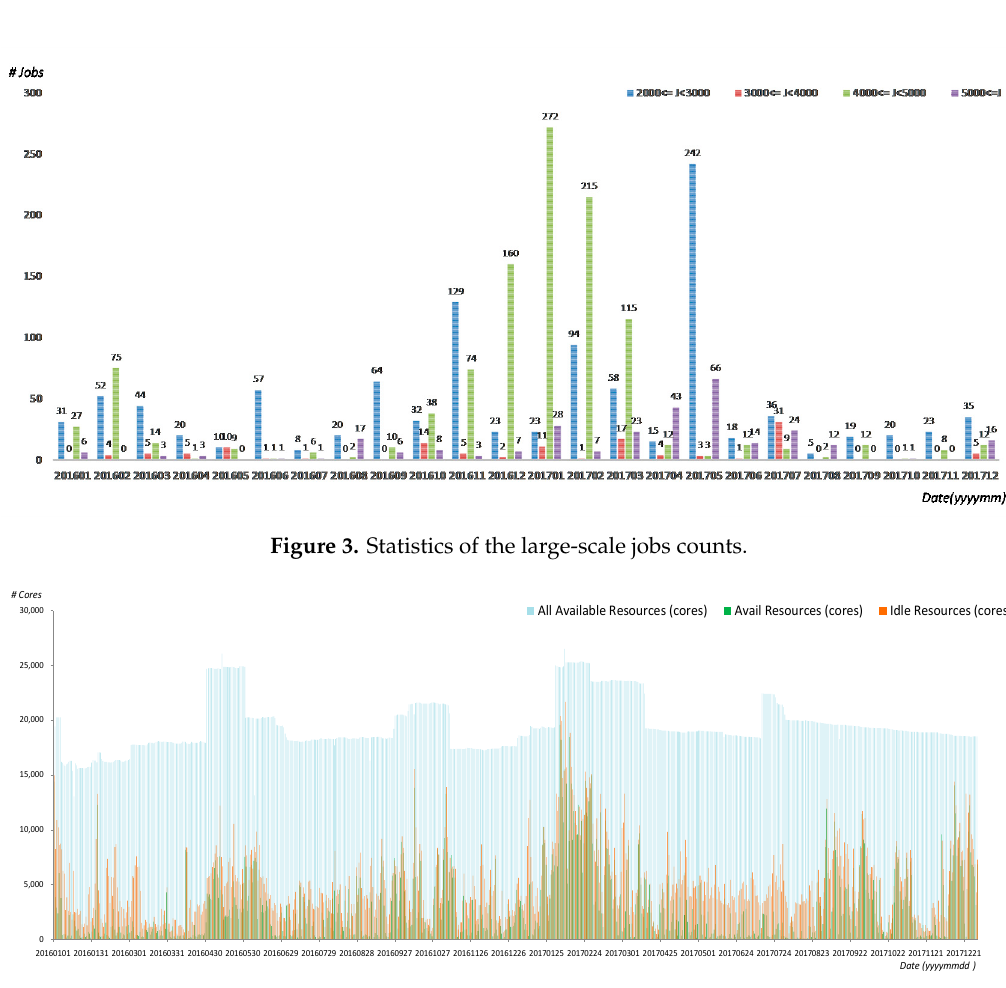
Figure 4. Statistics of the public queue available nodes.